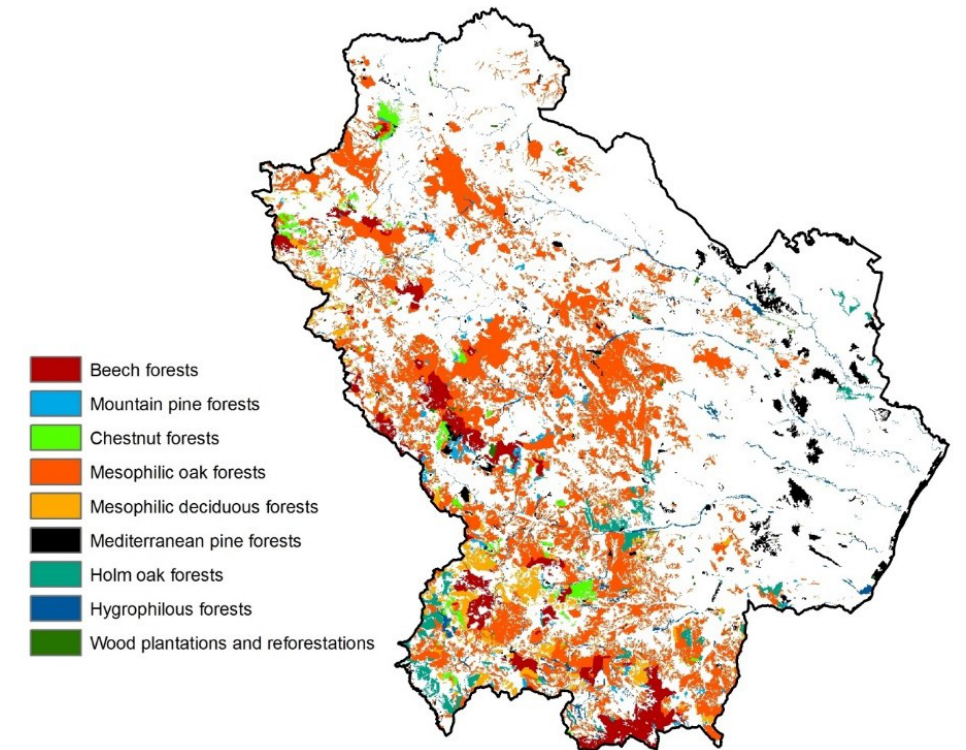
Figure 2. Reclassified regional forest